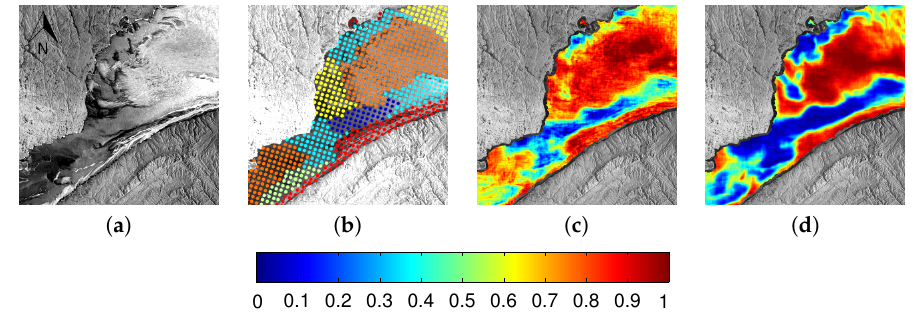
Figure 10. The network with three convolutional layers ( d ), improves the estimation for new ice compared to network with two convolutional layers ( c ). Panel ( a ) is the HH image, and ( b ) is the image analysis chart. Subscene of dimension 8 km × 8 km centered at 47.06 ◦ N and 64.46 ◦ W from 20140117_103914.